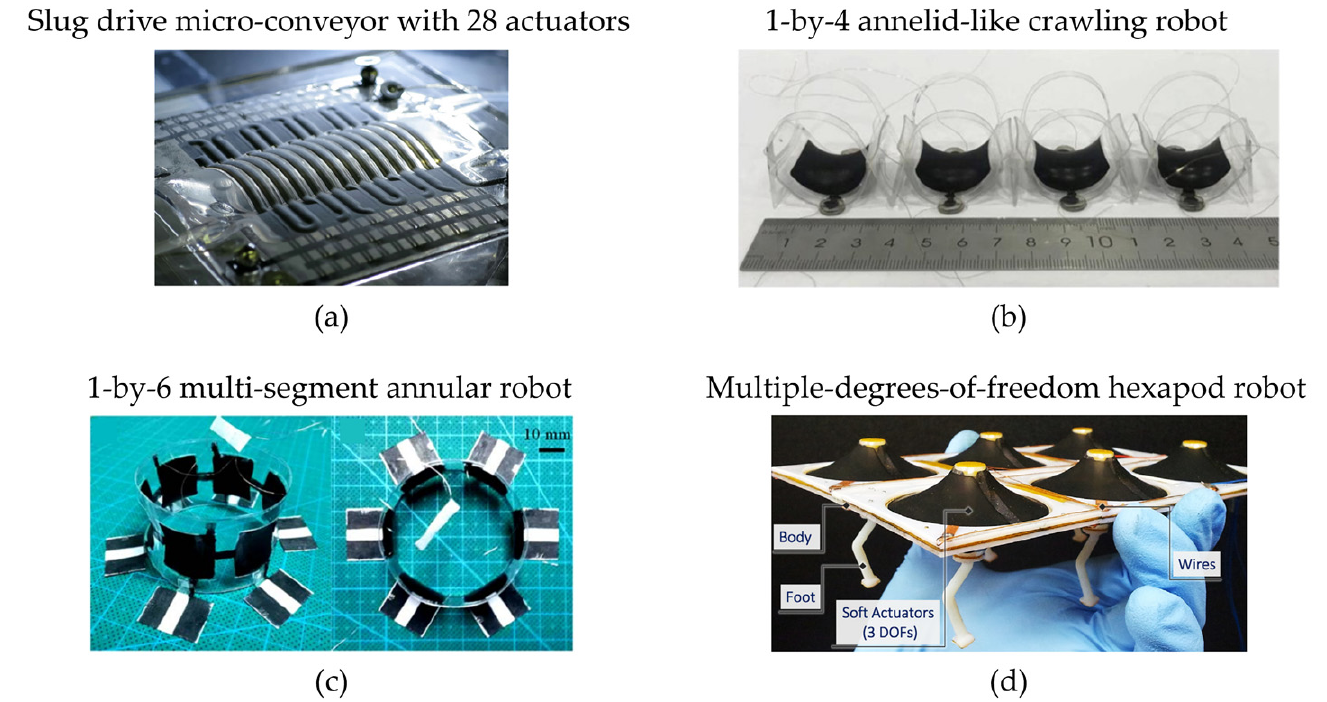
Figure 9. Examples of DEA bio ‐ inspired robots: ( a ) Slug drive micro ‐ conveyor with 28 integrated actuators [131]; ( b ) 1 ‐ by ‐ 4 annelid ‐ like peristaltic crawling robot [135], reproduced with permission from IOP Publishing Ltd., copyright 2020; ( c ) 1 ‐ by ‐ 6 multi ‐ segment annular soft robot [136], repro ‐ duced with permission from IOP Publishing Ltd., copyright 2018; ( d ) Multiple ‐ degrees ‐ of ‐ freedom walking hexapod robot [139], reproduced with permission from Elsevier, copyright 2017.